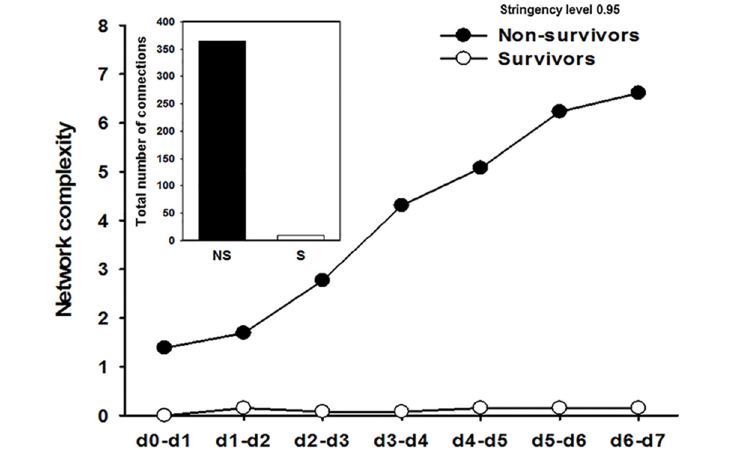
Figure 5. Dynamic network analysis (DyNA) of circulating inflammatory mediators in PALF patients (age-matched survivors versus nonsurvivors). Circulating inflammatory media- tors in serum samples from PALF spontaneous survivors (S, n = 45 patients) that closely matched nonsurvivors (NS, n = 12 patients) were measured and DyNA (stringency level = 0.95) was performed, as described in Materials and Methods. The figure shows the network complexity during each of the seven time frames calculated, as described in Materials and Methods, and the total number of connections for each group of patients over all time intervals (inset).